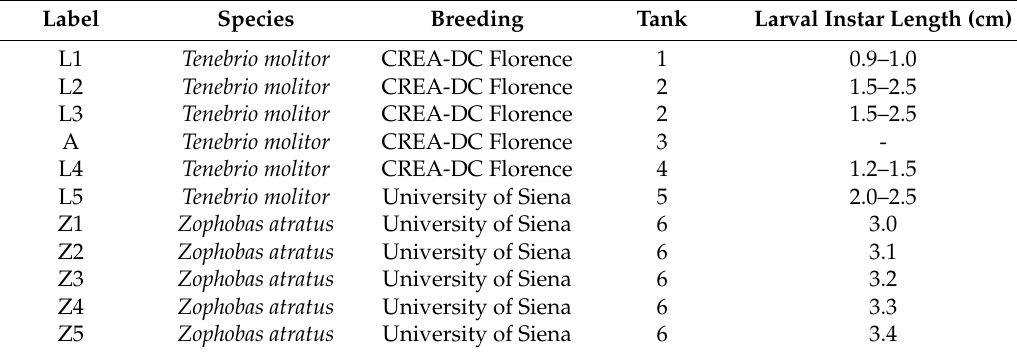
Table 1. List of the insect specimens applied for both the “population genetics” and the “single trophozoites” approach. The place and the tank in which the coleopteran species were bred are also